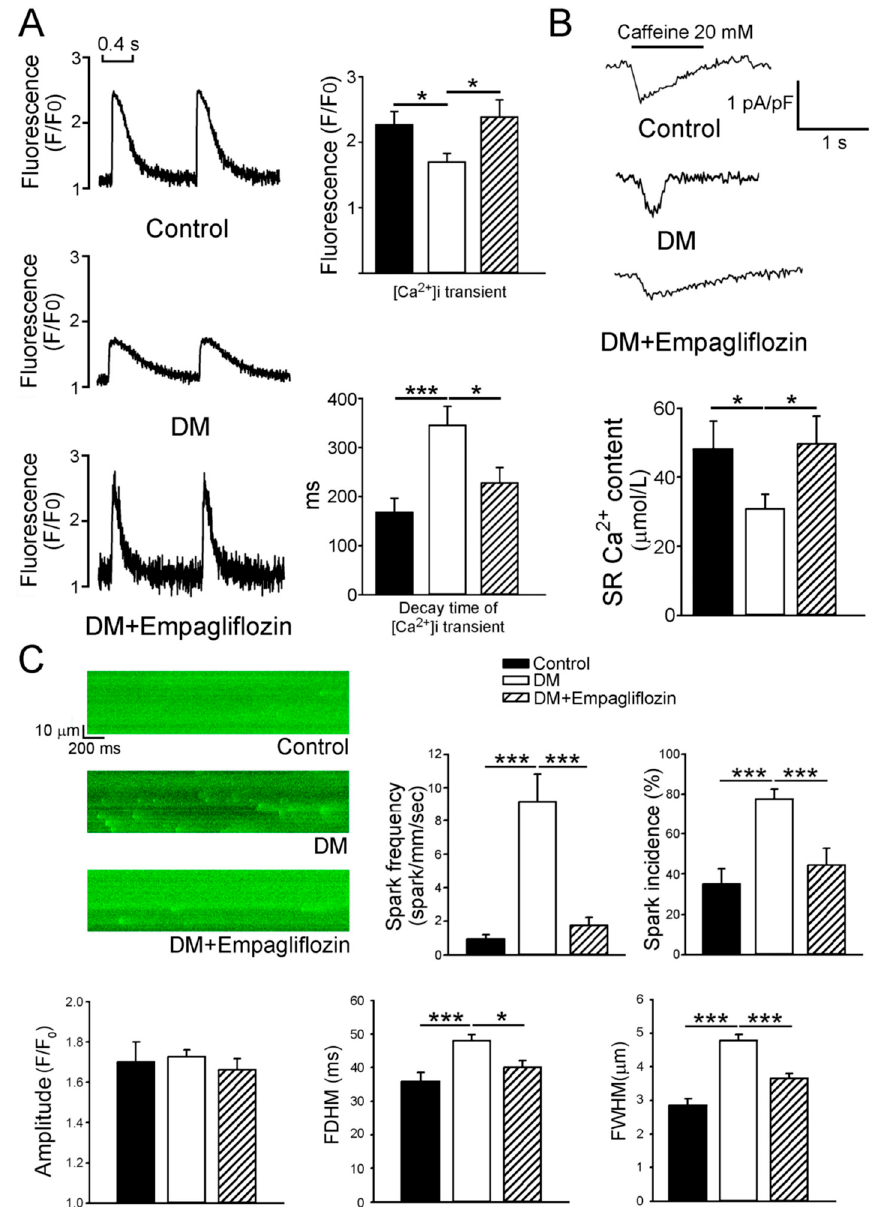
Figure 2. Intracellular Ca 2+ ([Ca 2+ ] i ) transients, calcium (Ca 2+ ) stores measured from caffeine (20 mM)-induced Ca 2+ transients and Ca 2+ sparks in ventricular myocytes from control, diabetes mellitus (DM), and empagliflozin-treated DM (DM + empagliflozin) rats. ( A ) Representative tracings and average data of [Ca 2+ ] i transients and decay of time of [Ca 2+ ] i transients in the ventricular myocytes recorded from control ( n = 46), DM ( n = 45), and DM + empagliflozin ( n = 46) rats. ( B ) Representative tracings and average data of Ca 2+ stores of ventricular myocytes recorded from the control ( n = 16), DM ( n = 13), and DM + empagliflozin ( n = 15) rats. ( C ) Representative tracings and average data of the incidence, frequency, amplitude, duration (full duration at half-maximal amplitude, FDHM), and width (full-width at half-maximal amplitude, FWHM) of Ca 2+ sparks in control ( n = 40), DM ( n = 76), and DM + empagliflozin ( n = 36) ventricular myocytes. n = number of cardiomyocytes isolated from those rats; * p < 0.05; *** p < 0.005.